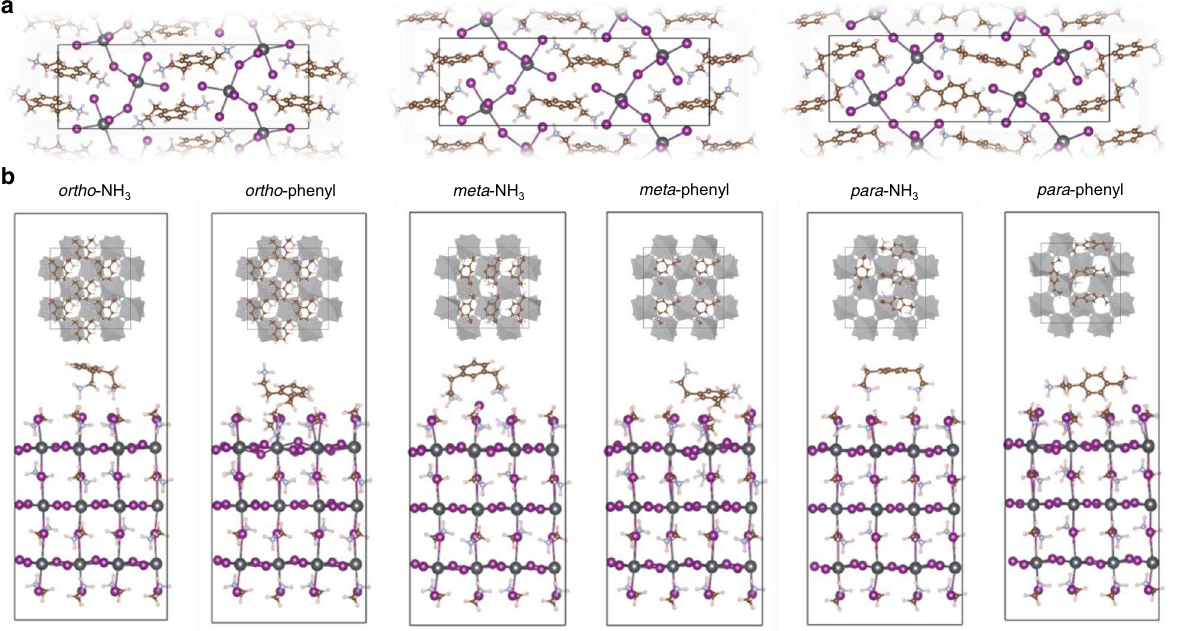
Fig. 2 Theoretical modeling. a Optimized 2D perovskites structures incorporating o -PDEAI 2 , m -PDEAI 2 , and p -PDEAI 2 . b Optimized structures for the adsorption of 2D cations on the perovskite surface. The top insets indicate the maximum number of PDEA cations that can be adsorbed on a 2 × 2 perovskite surface. Schematic is based on the optimized coordinates of the corresponding structures and translating them in multiple numbers. For the o - PDEAI 2 structures, both the modes adsorb in a similar